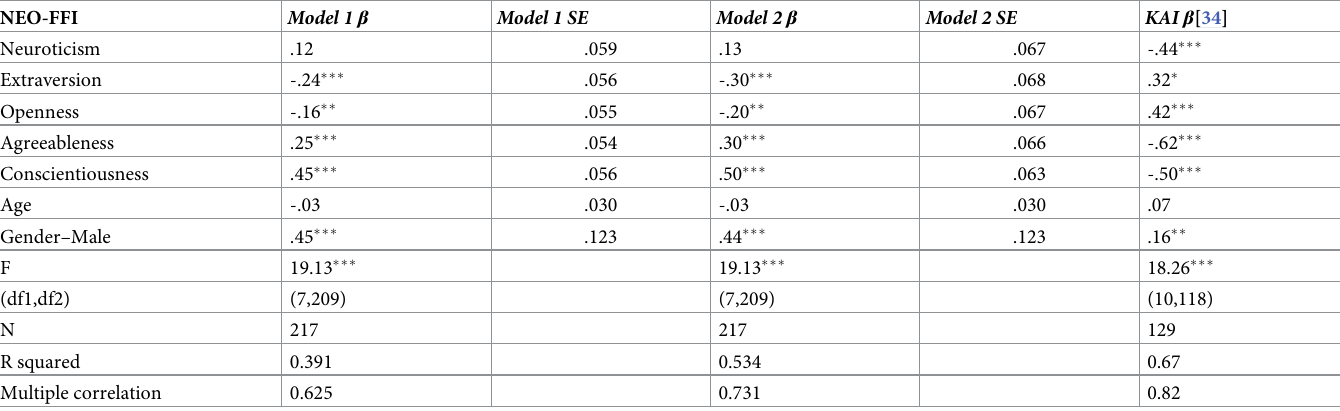
Table 3. Regression analyses for the two models with the NEO-FFI.